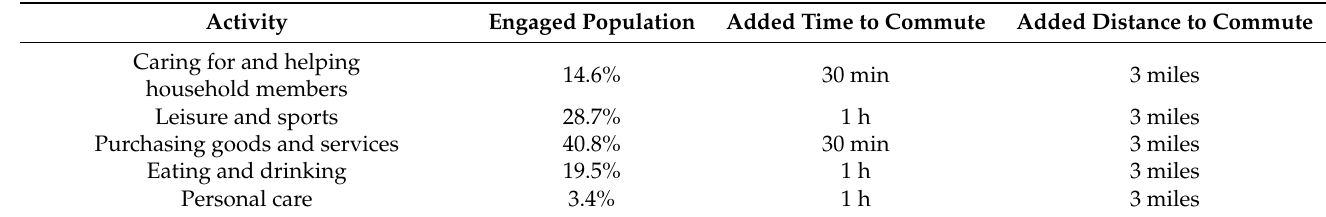
Table 2. Common activities people engage in after work.